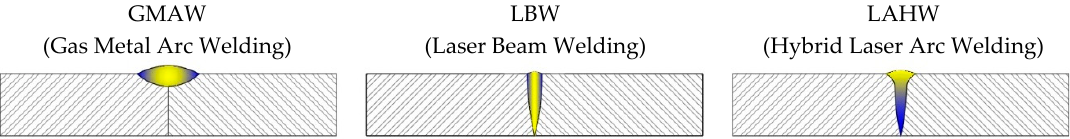
Figure 1. Cross section of weld beads joined by different welding processes: GMAW, LBW and LAHW.